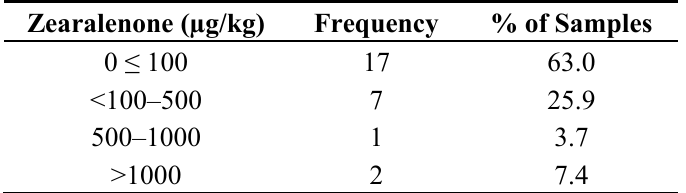
Table 5. Distribution of zearalenone levels in maize kernel